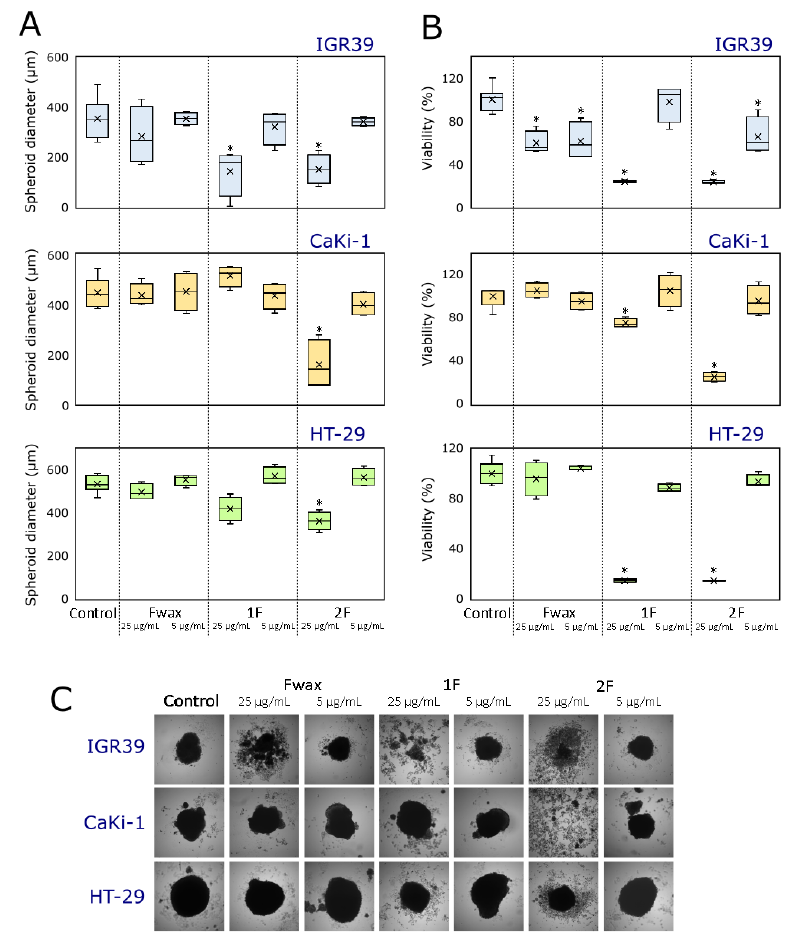
Figure 5. Cytotoxicity of F wax , 1F, and 2F in 3D cell cultures. ( A ) Diameter of HT-29, IGR39, and CaKi-1 spheroids at concentrations of 5 and 25 µ g/mL. ( B ) Cell viability in HT-29, IGR39, and CaKi-1 spheroids at concentrations of 5 and 25 µ g/mL. ( C ) Photos of cancer spheroids after 8 days. Asterisks (*) indicate statistically significant differences ( p < 0.05) compared to the control (untreated